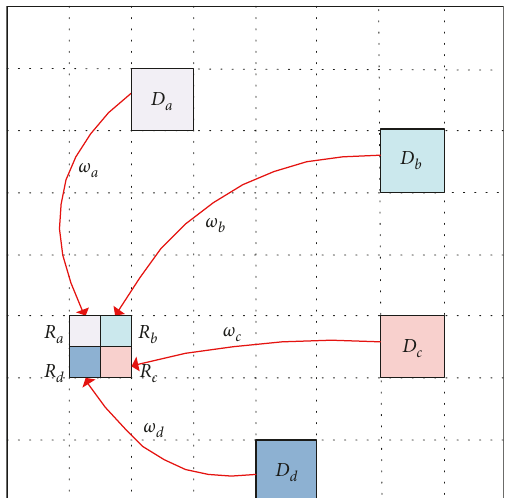
Figure 3: Block mapping of quadtree